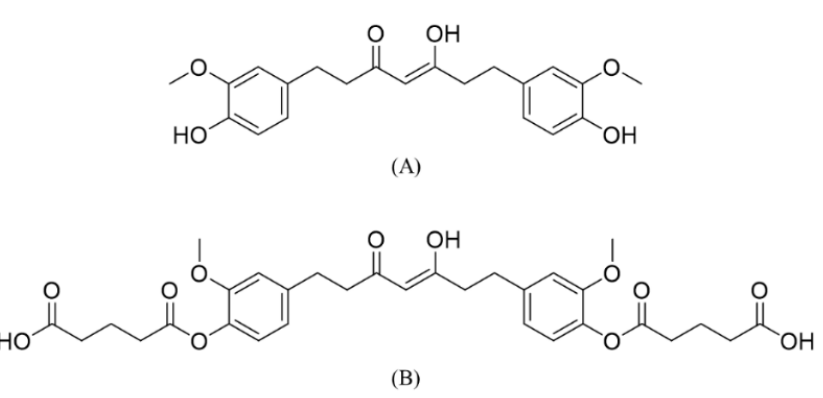
Figure 1. Chemical structures of ( A ) tetrahydrocurcumin (THC) and ( B ) tetrahydrocurcumin ‐ diglutaric acid (TDG).